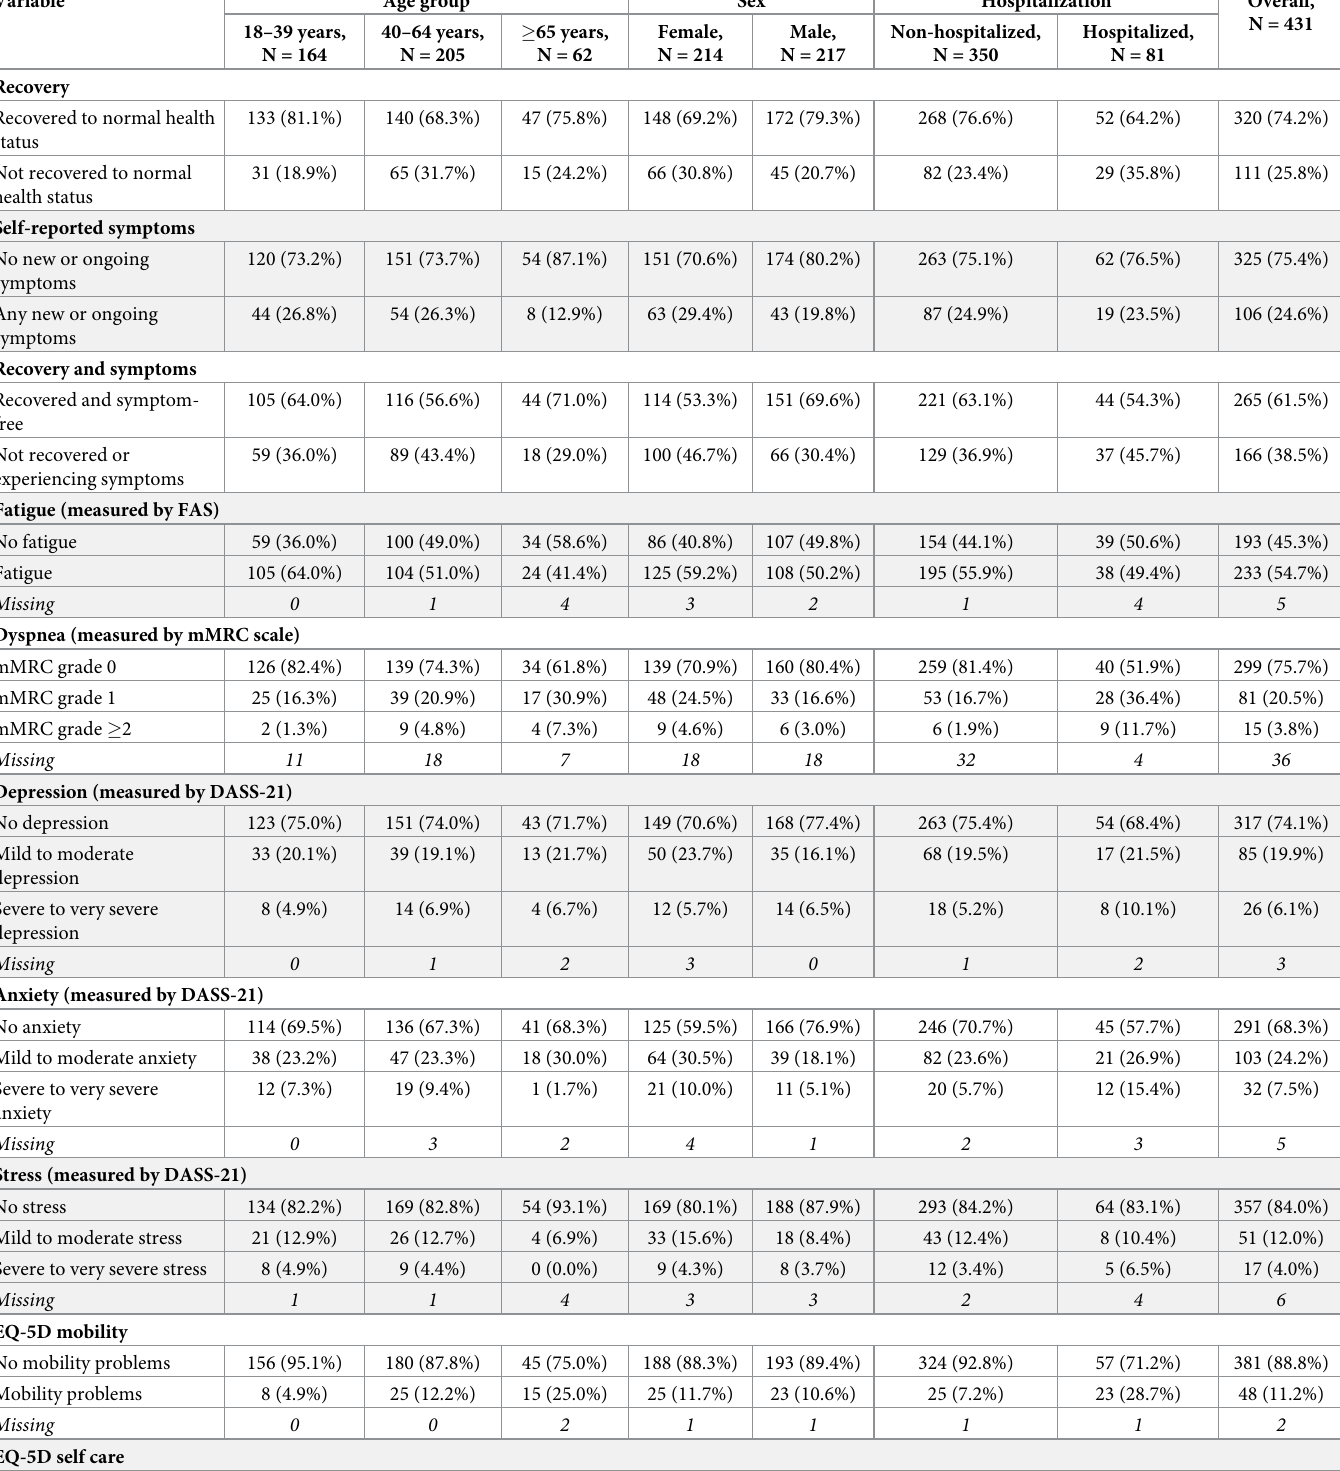
Table 2. Relative health status, fatigue, dyspnea, mental health, and health-related quality of life in study participants at six to eight months after SARS-CoV-2